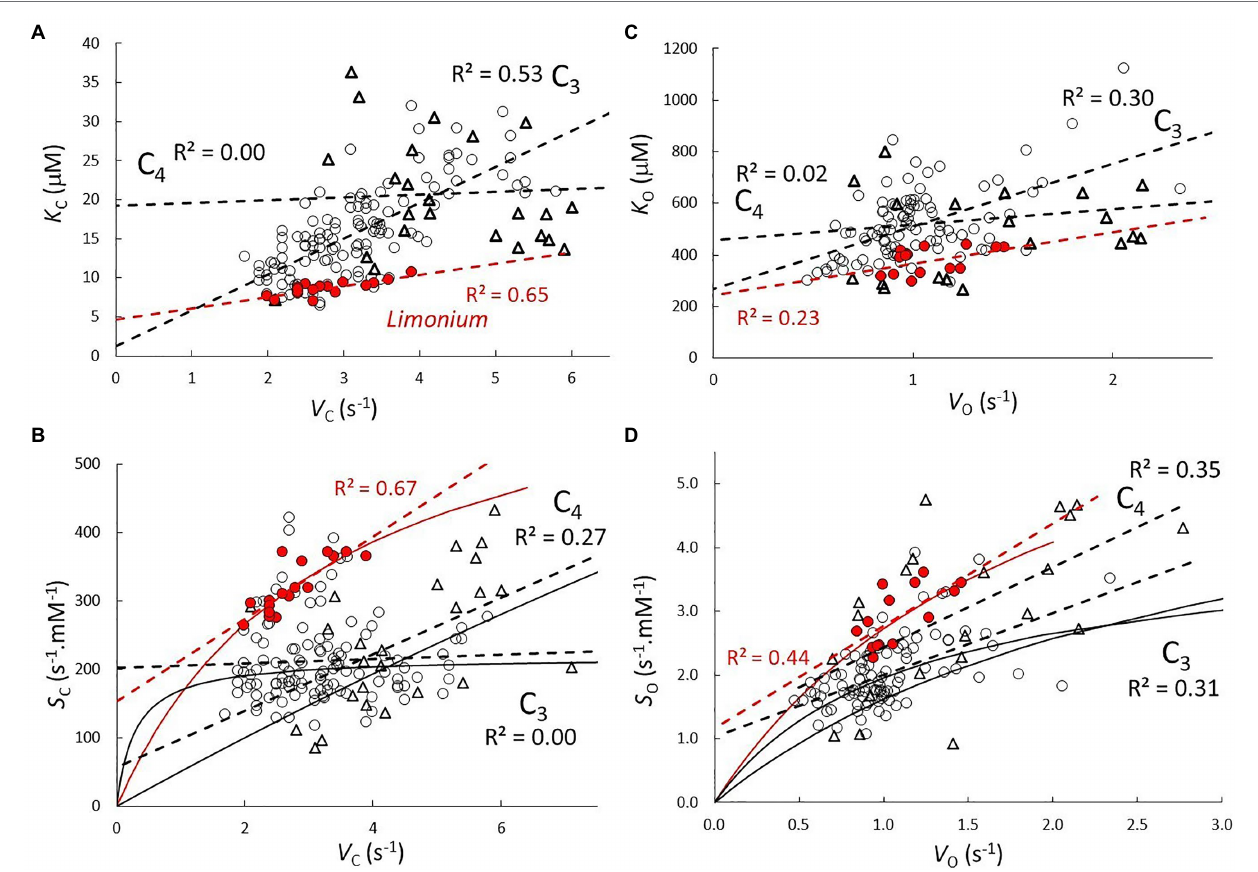
FIGURE 1 | Correlations between parameters V max , K M , and S from (A,B) carboxylase and (C,D) oxygenase reactions. Scatter plots and lines (dash) of best fit with R 2 for C 3 ( ○ ), C 3 Limonium (highlighted in red), and C 4 ( ∆ ) plant RuBisCO parameters. Solid lines in ( B ; S C vs. V C ) and ( D ; S O vs. V O ) are predictions of the actual curves (Equation 7) based on coefficients ( Table 2 ) obtained from regression of data in (A,C) ,